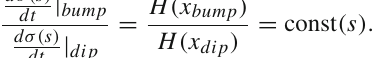
Table 6 Summary table of the elastic cross-sections σ el , the nuclear slope parameters B , with references. We have indexed with superscript A the type A, point-to-point fluctuating systematic and statistical errors, that can be added in quadrature, while type B errors (point-to-point changing, fully correlated systematic errors) are indicated with super- scriptBandtypeCerrors(overallcorrelated,but − t independenterrors) areindicatedwithsuperscript C.NotethatthevalueandthetypeAerror √ s = 1 . 96 TeV [*] is obtained from of the elastic cross-section σ el at a low − t exponential fit to data of Ref. [8], while the type C error is